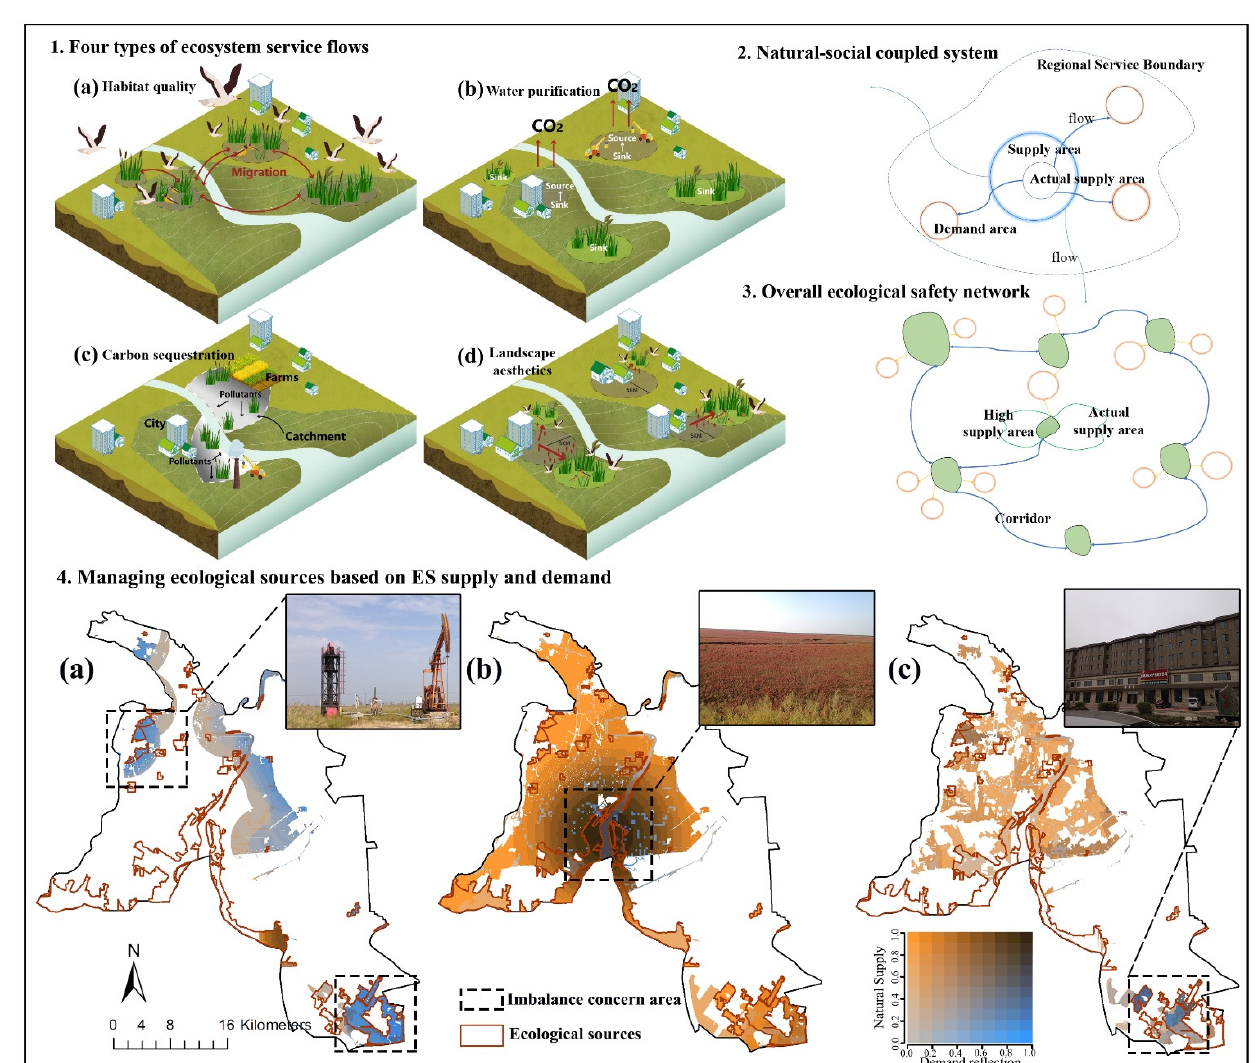
Figure 6. Ecological management logic and application: ( 1a ) protection of habitat patches indicative of the physical presence of birds; ( 1b ) protection of carbon sinks that are undergoing severe disturbance; ( 1c ) protection of patches that perform the function of purifying pollutants emitted by humans that flow into water systems; ( 1d ) attention to natural patches within people’s living circles; ( 2 ) Connecting natural-social systems through ecosystem service flows; ( 3 ) A part of the high supply area, the actual supply area and corridors together form an overall ecological safety network; ( 4 ) pairwise comparisons were made between the natural service potential and demand-reflecting values of different ecosystem services with SBA as the boundary; ( 4a ) landscape aesthetics; ( 4b ) habitat quality; ( 4c ) water purification.